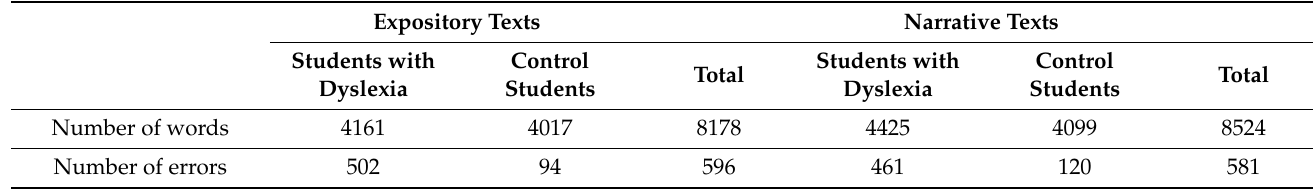
Table 3. Length indicators for written texts according to text type and